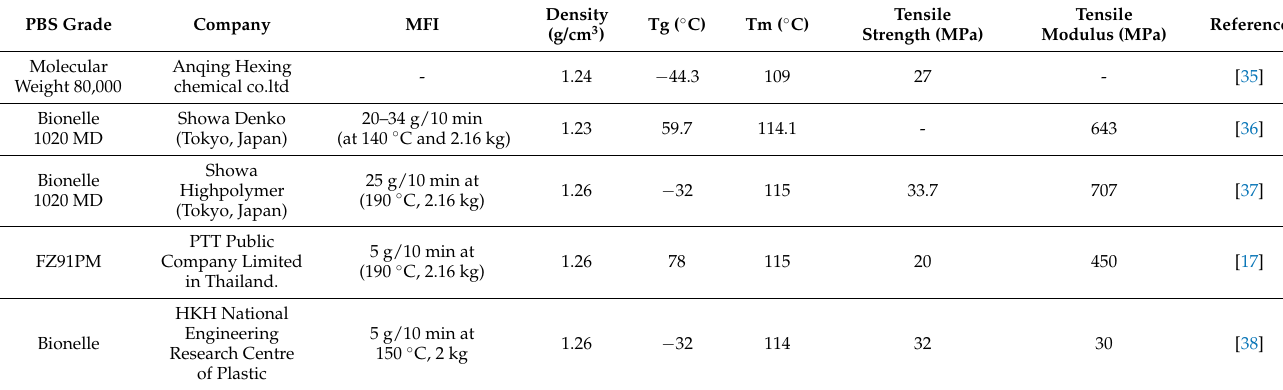
Table 1. Properties of different grades of PBS. T m : melting temperature; T g : glass transition temperature.